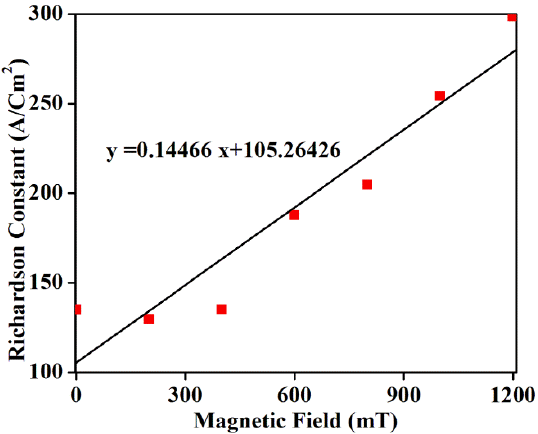
Figure 10. Magnetic field dependent Richardson constant for GDG